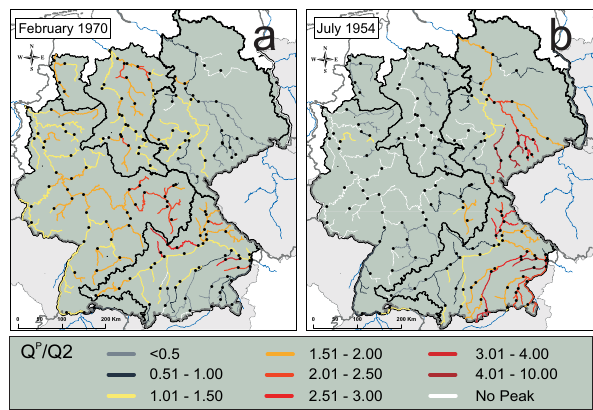
Fig. 6. Characteristics of (a) the winter flood in February 1970 (22.2.–4.3.1970, Duration: 11 days, Rank 2, L =72.9%, S =114.0) and (b) the summer flood of July 1954 (2.7.–31.7.1954, Duration: 30 days, Rank 12, L = 36.1%, S = 81.7). The river network is coloured according to the regionalisation of the normalised peak discharges with colours from yellow to red indicating significant peaks above the threshold κ =Q2. Grey shaded river stretches still exhibited significant peaks but did not exceed κ =Q2. At river stretches coloured white no flow reaction could be observed during the